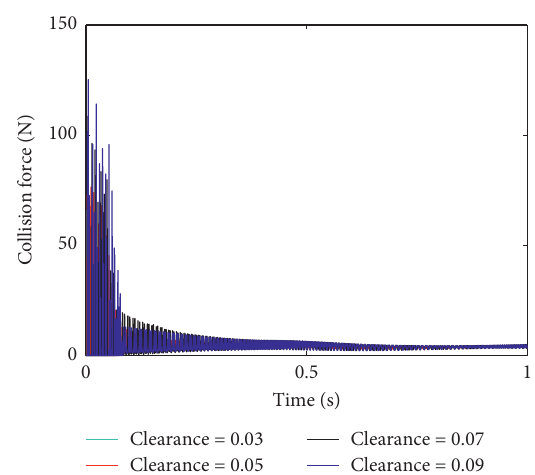
Figure 17: Collision force with different clearance